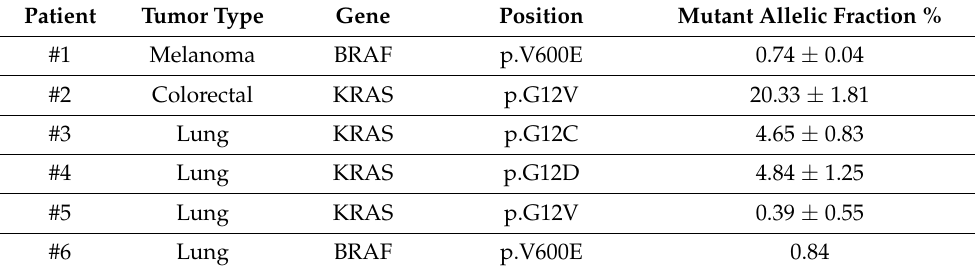
Table 5. Mutational analysis of KRAS and BRAF genes in plasma-derived EV-DNA by TaqMan.